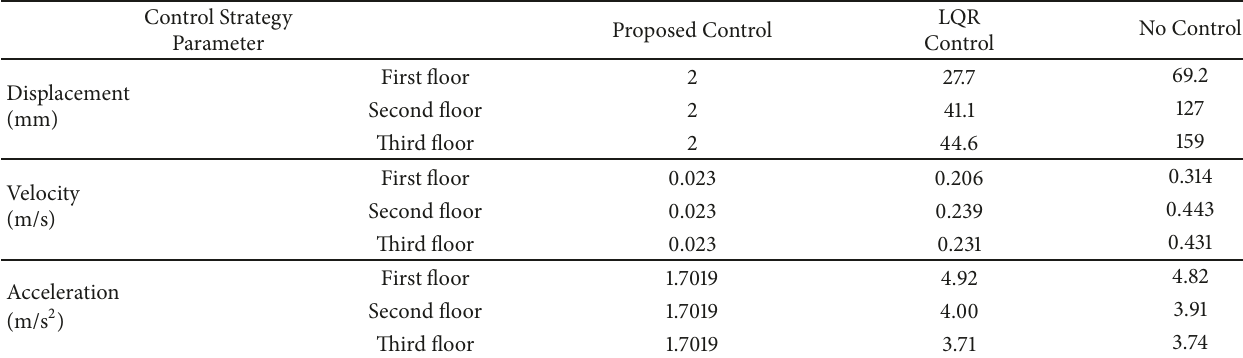
Table 1: Maximum displacement, velocity, and acceleration of in Example 1.